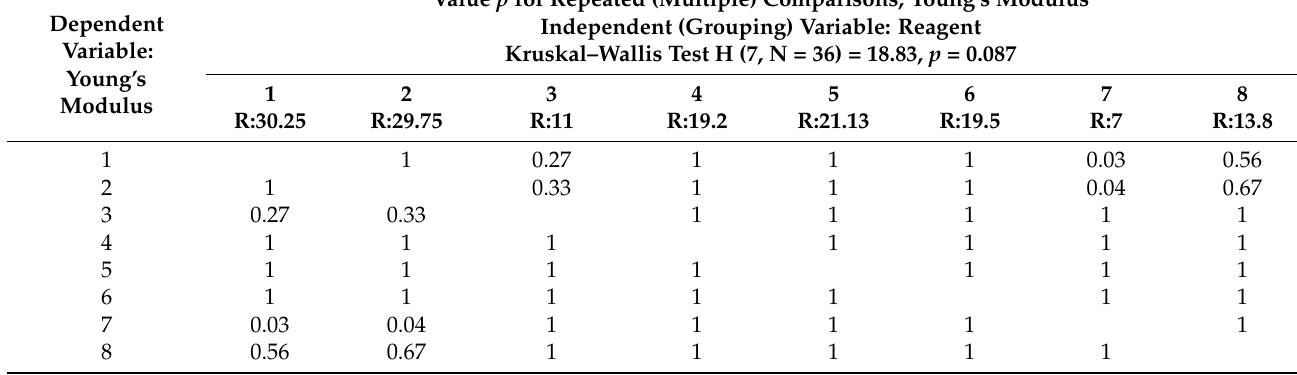
Table 5. Results of repeated (multiple) comparisons.